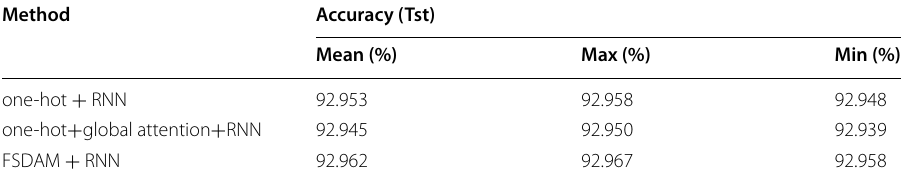
Table 13 Accuracy of different methods on UNSW-NB15 Method